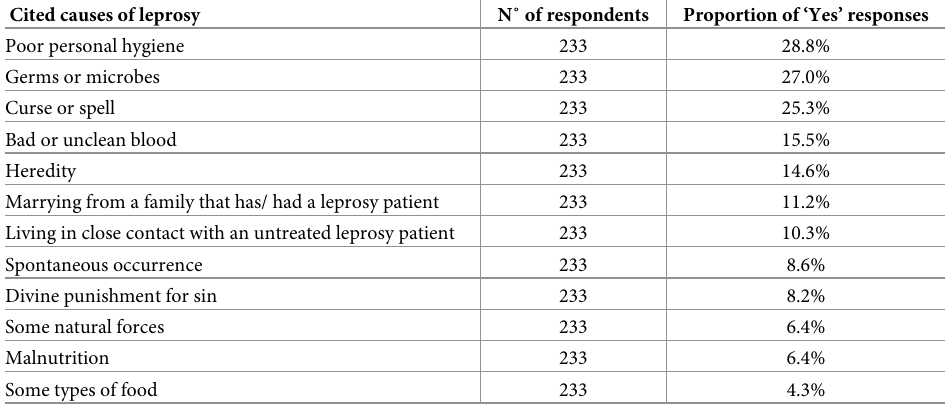
Table 3. Causes of leprosy as cited by the